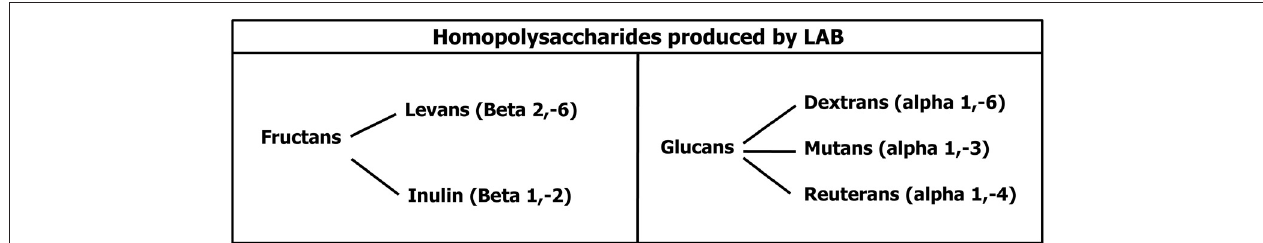
FIGURE 4 | Homopolysaccharidesbiosynthesized by Lactic Acid